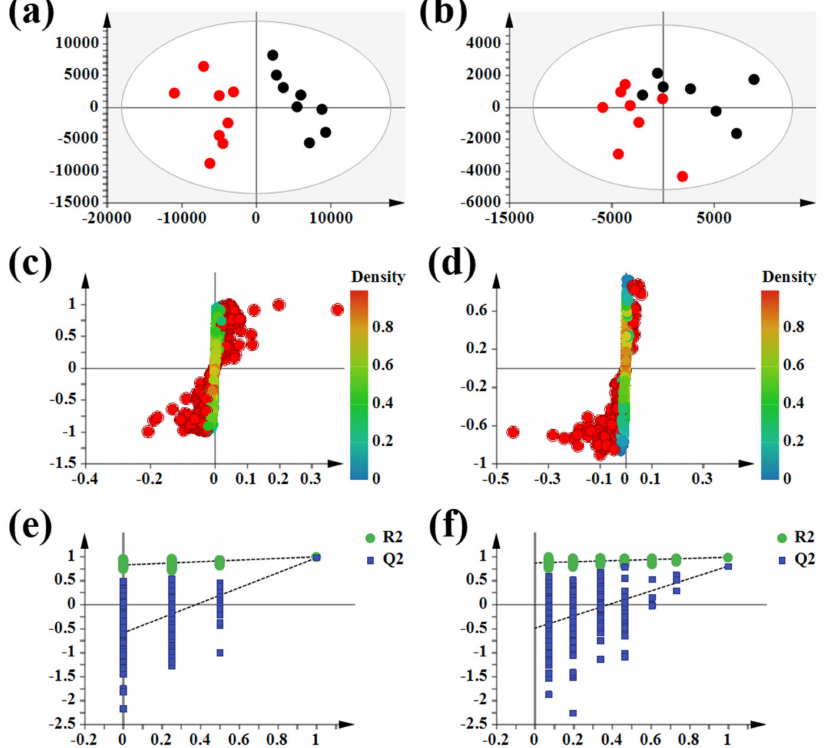
Figure 3. Multivariate statistical analysis of control groups and model groups. Note: ( • ) = control group and ( • ) = model group. ( a ) PCA scores plotted in positive mode. ( b ) PCA scores plotted in negative mode. ( c ) S-plot in positive mode. ( d ) S-plot in negative mode. ( e ) Permutation plot in positive mode. ( f ) Permutation plot in negative